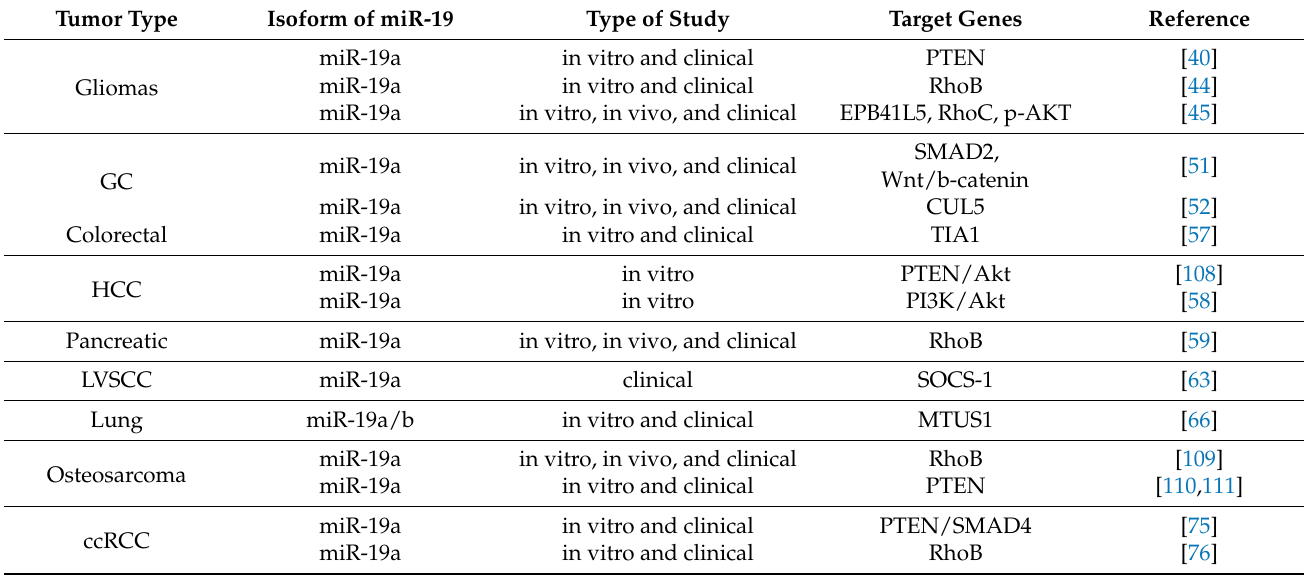
Figure 1. miR-19a and its main target genes. The figure summarizes the interactions between miR-19a and the target genes on which it acts, also indicating each their main biological effects. Table 1. This table summarizes the relationship between the miR-19a isoform and its target genes in several types of cancers.